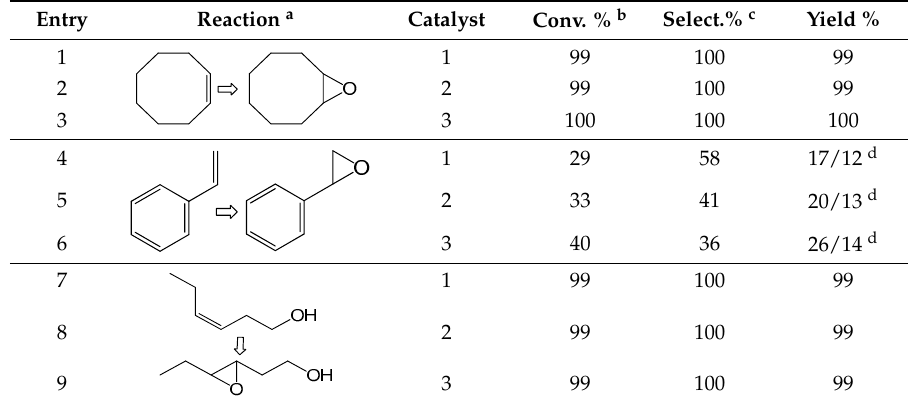
Table 3. Olefin epoxidation of cis -cyclooctene (cy8), styrene (sty), cis -hex-3-en-1-ol ( cis ), trans -hex-3- en-1-ol ( trans ), geraniol (ger), and 1-octene (1-oct) catalyzed by complexes 1 – 3 . Entry Reaction a Catalyst Conv. % b Select.% c